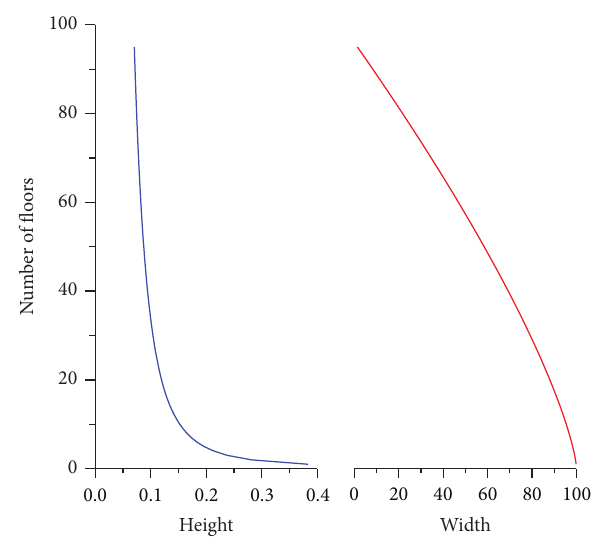
Figure 8: Showing the heights and widths of the floors with respect to the number of floors.